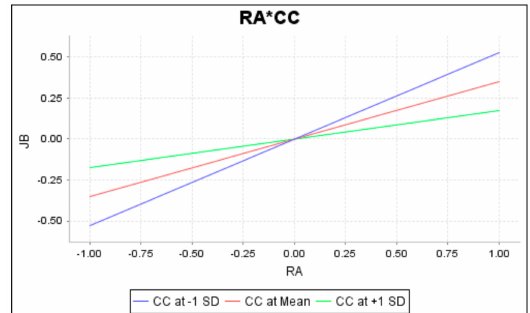
Figure 3. Moderation of career calling on the relationship between role ambiguity and job burnout.